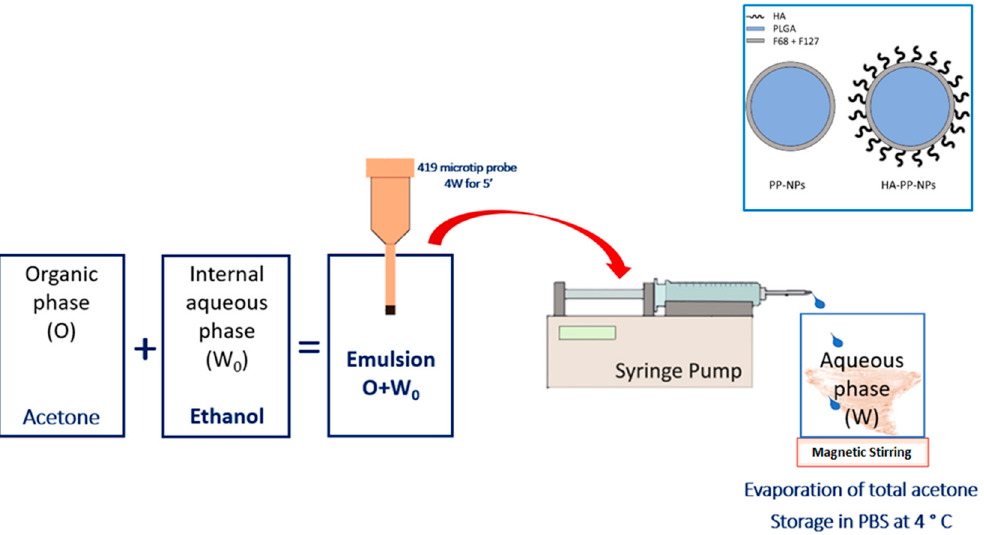
Figure 5. Schematization of NP formulation process with the nanoprecipitation technique. The inset in the upper right corner shows the two possible formulations.